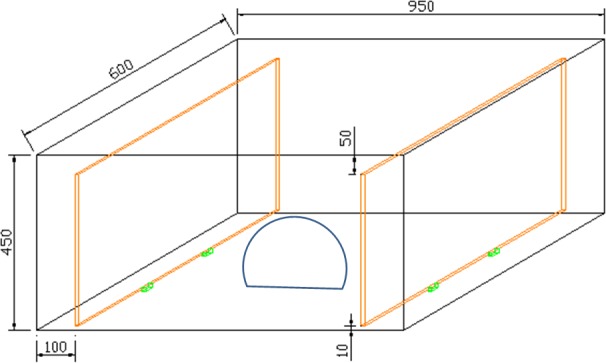
Experimental set-up of the binary choice experiment in the laboratory (metric unit: mm).